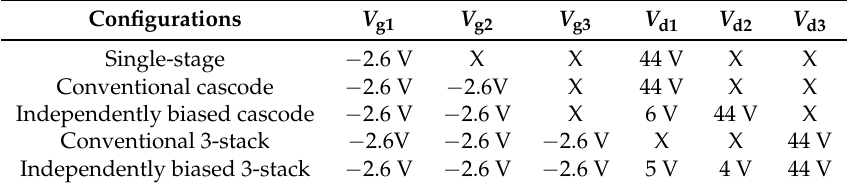
Table 3. Bias condition of configurations for large-signal (LS)